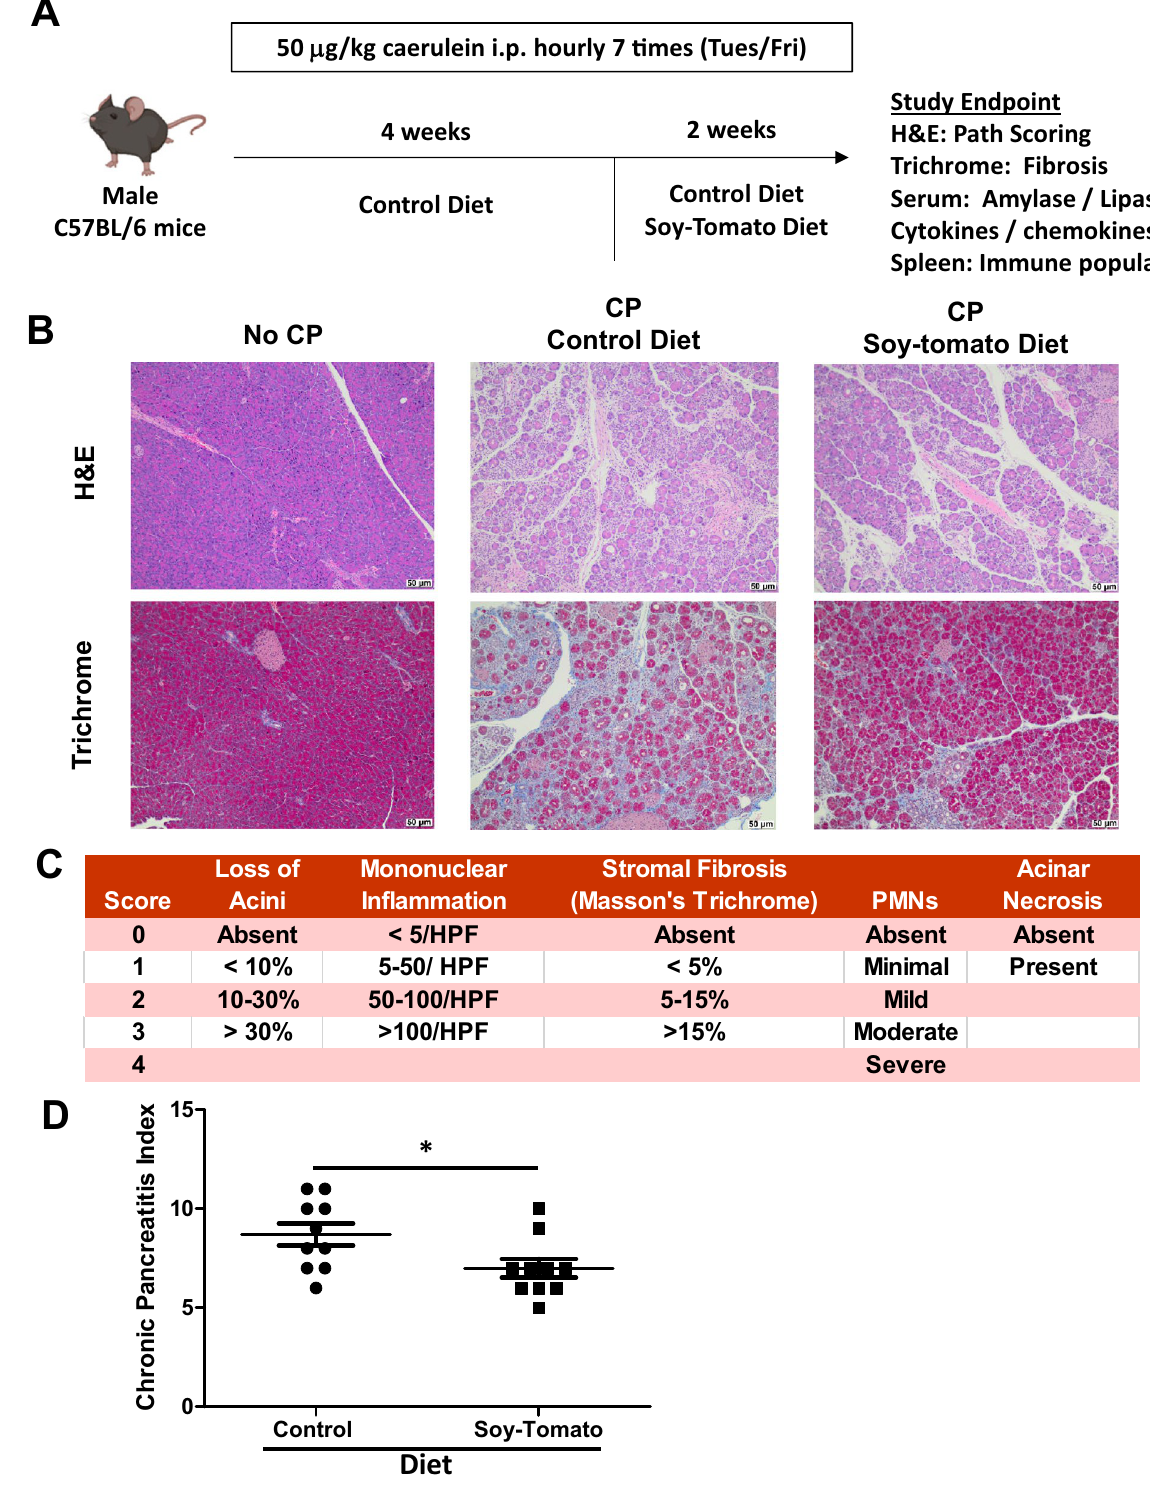
Figure 1. Soy-Tomato enriched diet reduces severity of chronic pancreatitis (CP). ( A ) C57BL/6 mice were injected intraperitoneally with 50 μg/kg caerulein (7 hourly injections, twice weekly) for 6 weeks. Mice across all groups were a fed a control diet from the start. After 4 weeks of injections, one group was fed a soy-tomato enriched dietary intervention ( B ) After 2 weeks of dietary intervention, severity of chronic pancreatitis was assessed from H&E and Trichrome stained pancreatic tissue at study endpoint. ( C ) Chronic pancreatitis index (score range 0–15) was expressed as a sum of scores for loss of acini, inflammation, necrosis, stromal fibrosis, polymorphonuclear cells (PMNs), and acinar necrosis; inflammation was measured for 10 random high power fields (HPF; 40× objective). Stromal fibrosis was evaluated in the entire pancreatic section on Masson’s Trichrome-stained slides. ( D ) Chronic pancreatitis index scoring was quantified across all mice from each study group with healthy no CP mice having an index value of zero (not shown). N = 10 mice/group (* p <